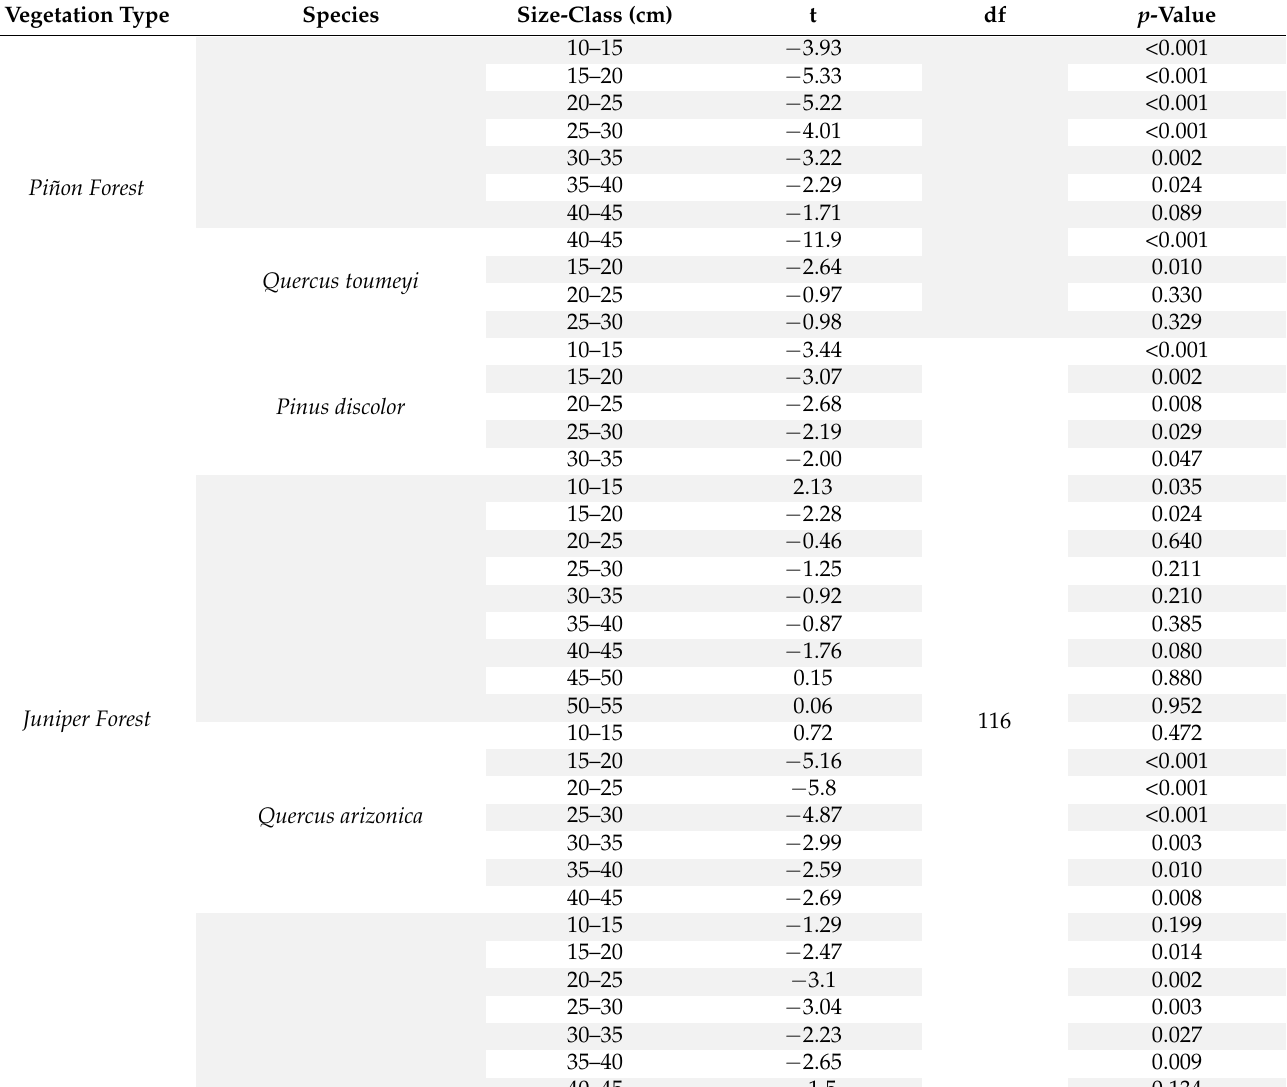
Table A3. Paired t -test significance table evaluating changes in the size structure of dominant tree species within each vegetation type in Chiricahua National Monument, Arizona,